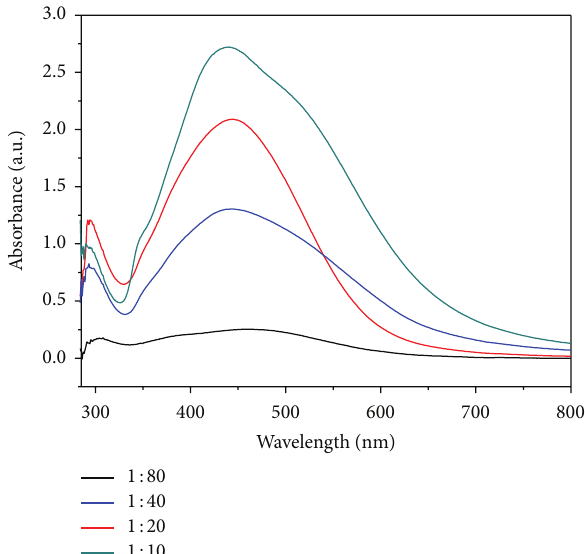
Figure 2: UV-visible absorption spectra of RR-SNPs on 120th day after preparation (variation of AgNO 3 in accordance with 4mL of RR).